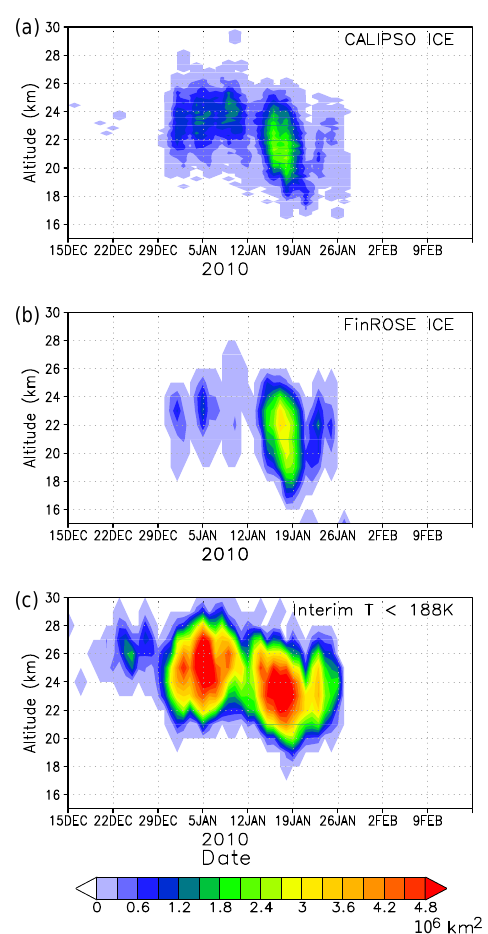
Figure 9. Ice PSC area from CALIPSO (a) , ice PSC area from FinROSE (b) , and (c) area colder than 188K from ECMWF ERA- Interim in the winter of